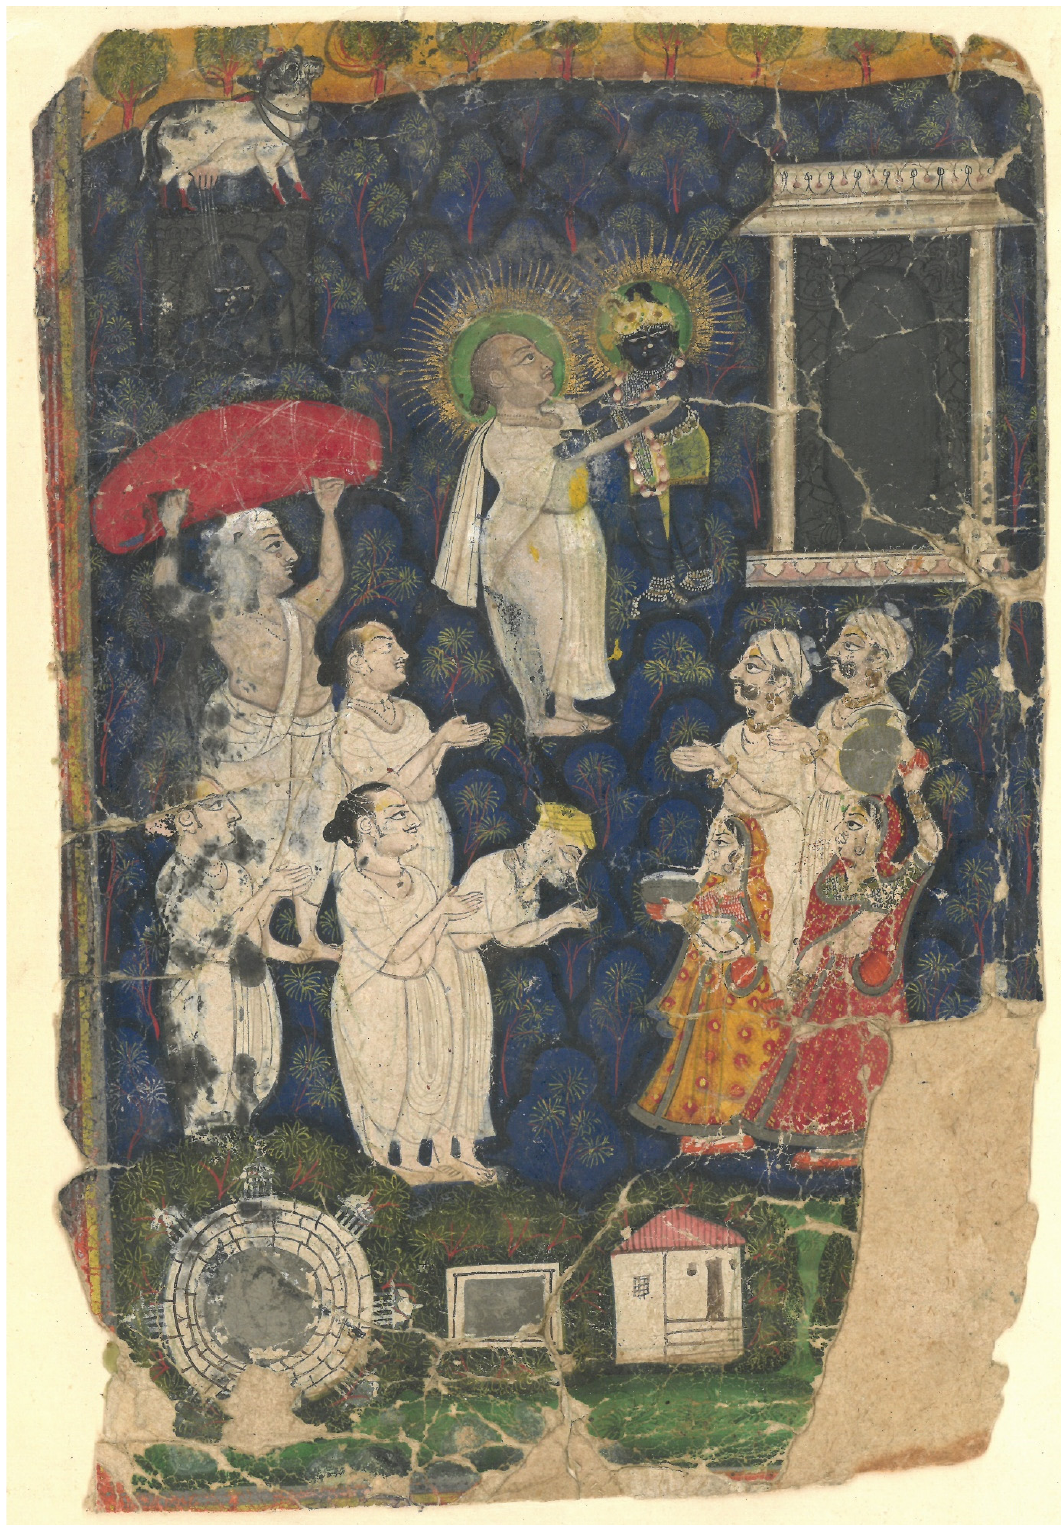
Figure 3. The image of Ś r ī N ā th is installed. Rajasthan 18th century (private collection).